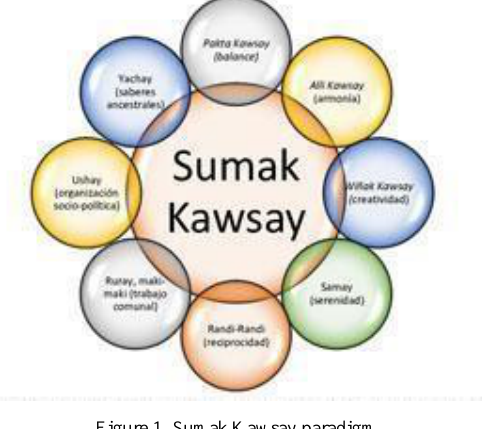
Figure 1. Sumak Kawsay